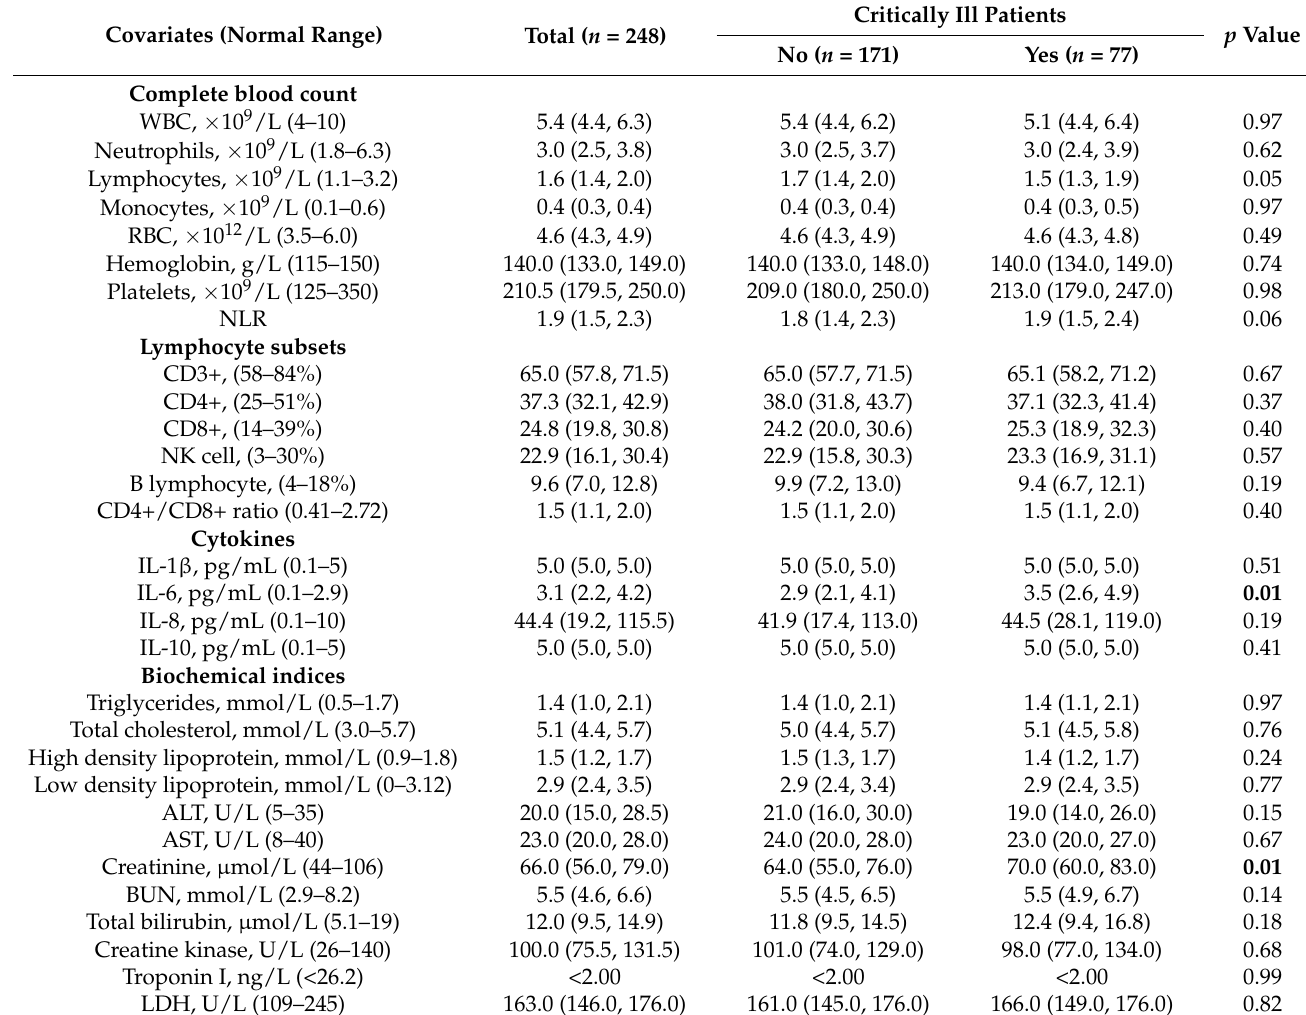
Table 3. Laboratory results at follow-up according to severity